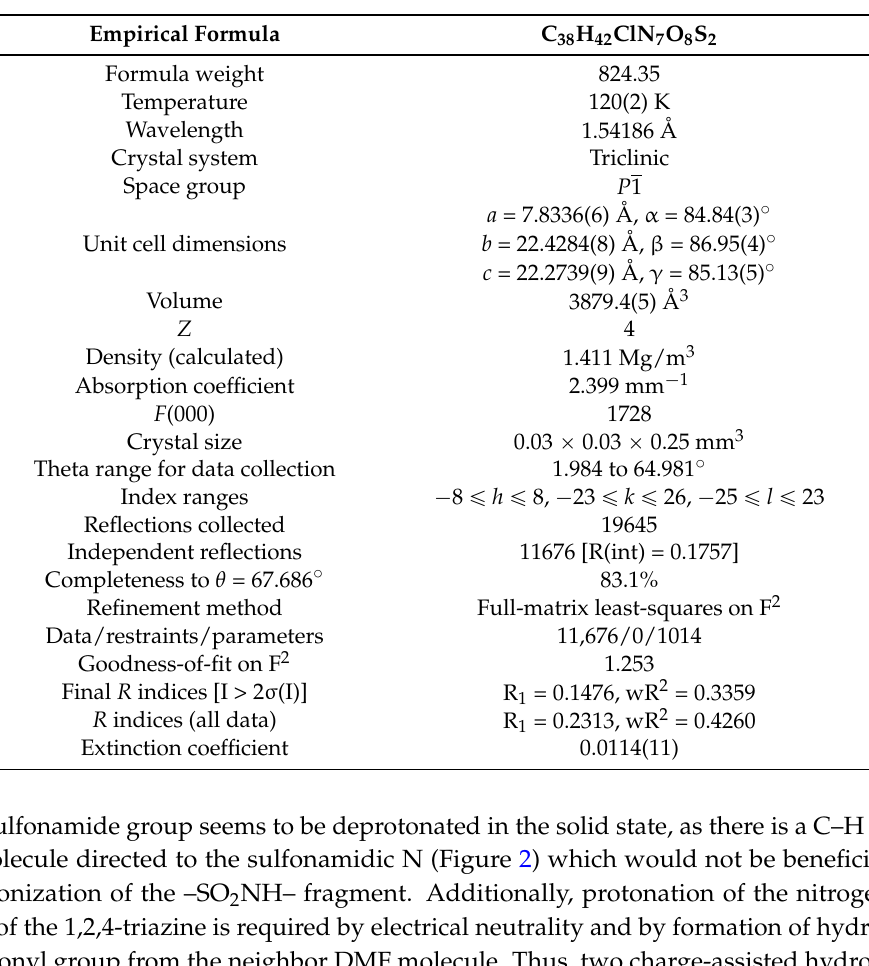
Table 1. Crystal data and structure refinement of 59 .